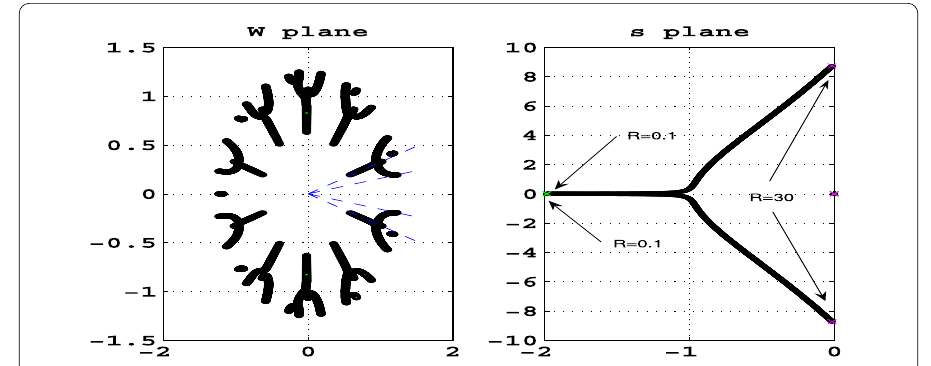
Figure 4 Poles in W -plane and s -plane with G = 0.1 and fractional orders α 1 = 0.99 and α 2 = α 3 = 1.